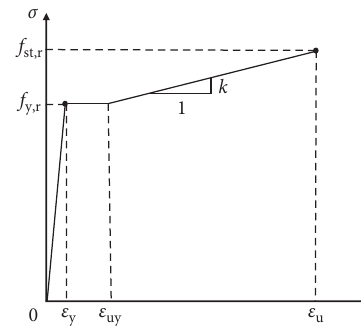
Figure 13: Stress-strain curve of steel reinforcement.